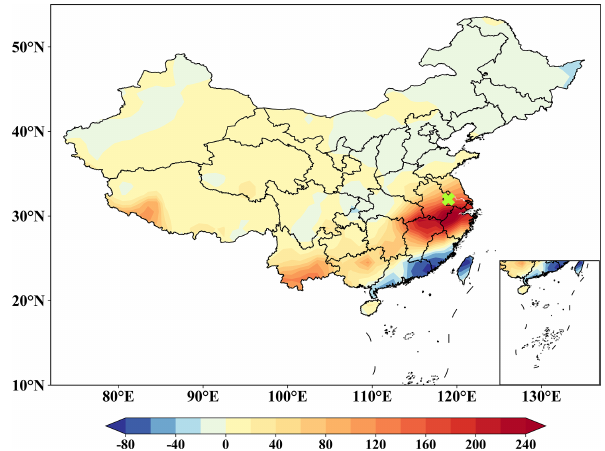
Figure 1. Winter (December–February) precipitation anomalies (shading; units in millimeters) over China in the winter of 2018– 2019. The cross symbols ( × ) represent the sampling site at Nan- jing. The anomalies were calculated with respect to the 1981–2010 climatology (precipitation data from the Global Precipitation Cli- matology